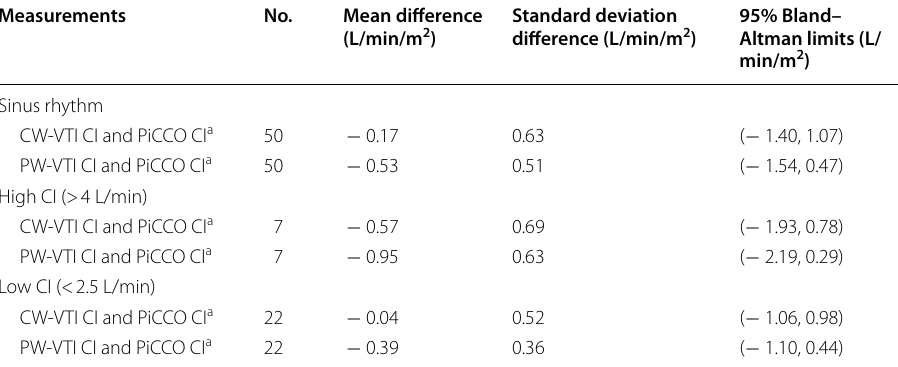
Table 4 Subgroup analysis for rhythm and cardiac index including mean differences between measurements, the standard deviation of the differences and the 95% Bland–Altman limits of